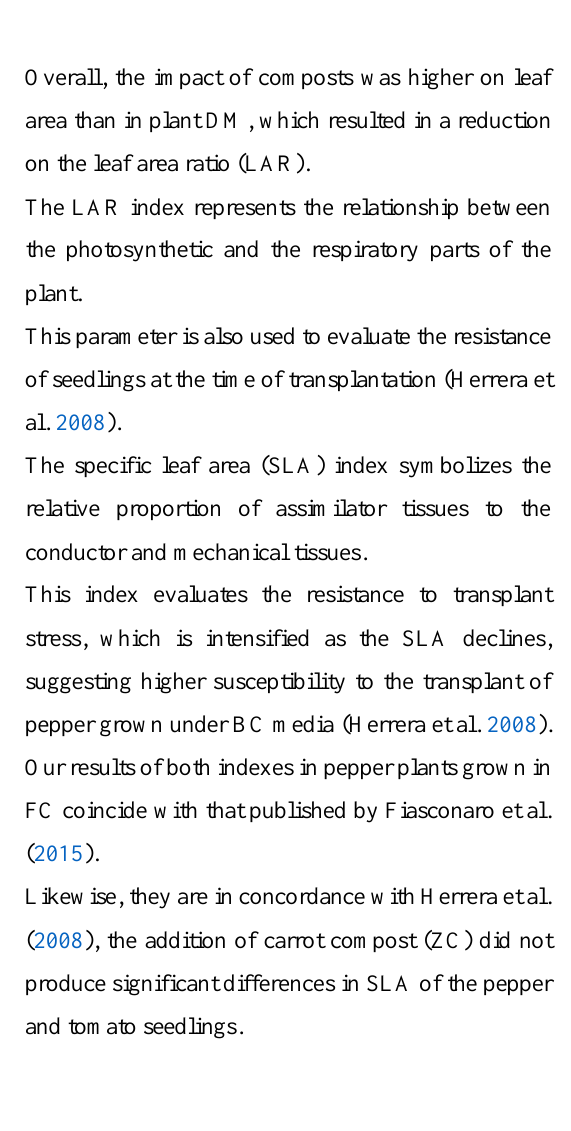
Fig. 1 Percentage of germination of a) pepper and b) tomato seedlings grown in perlite amended with different doses of compost Carrot compost (ZC), fat compost (FC) and biosolids compost (BC). A commercial substrate (CS) was used as a control treatment. Values are means ±S.E. (n=9). Bars topped by the same letter do not differ significantly (P≥0.05) according to Duncan’s